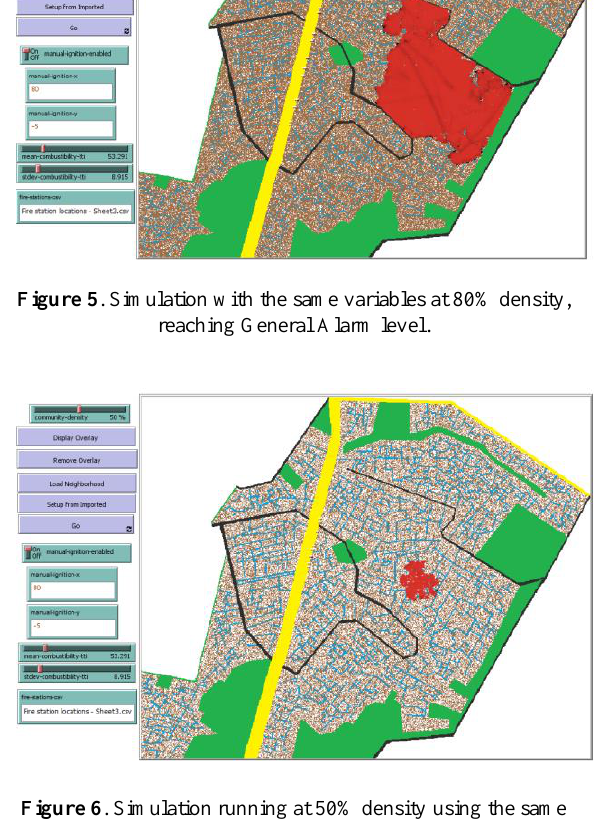
Figure 6 . Simulation running at 50% density using the same variables as Figures 4 and 5.